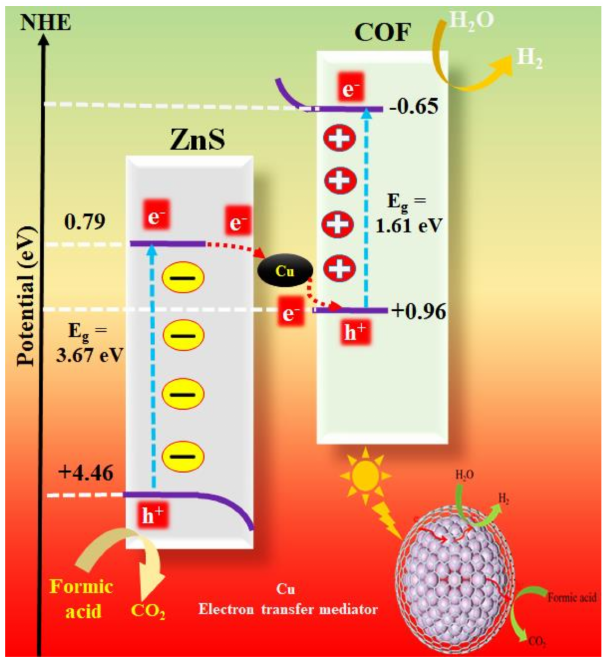
Figure 8. The photocatalytic hydrogen evolution mechanism by Cu/ZnS/COF